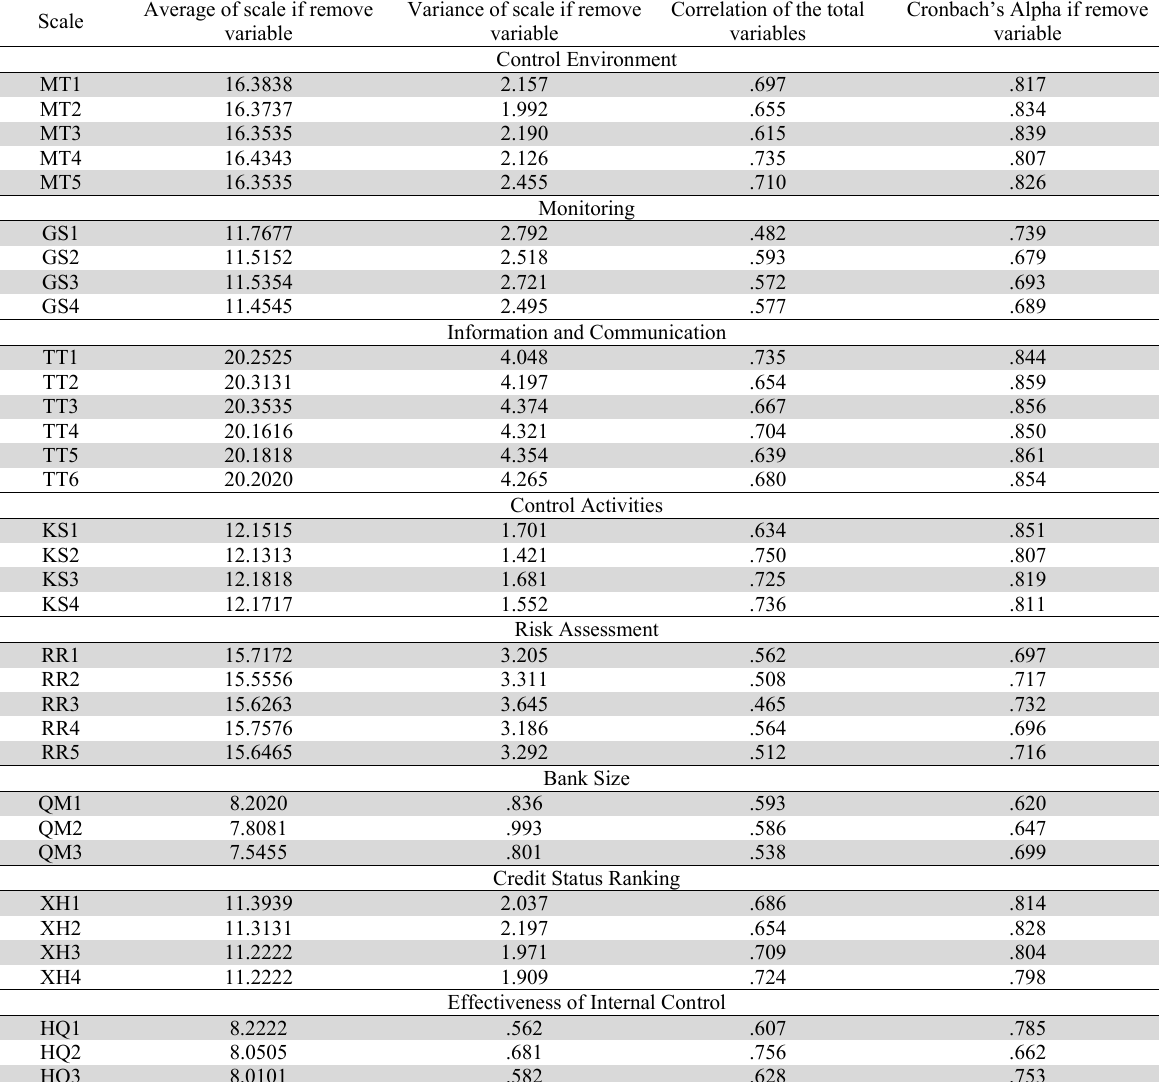
Results of running Cronbach’s Alpha audit analysis Scale